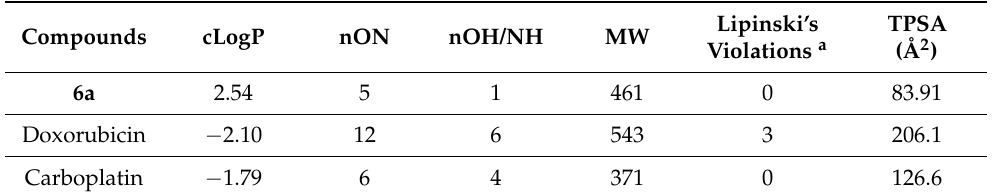
Table 4. Physico-chemical descriptors related to pharmacokinetic properties 6a in comparison to the chemotherapy drugs doxorubicin and carboplatin.